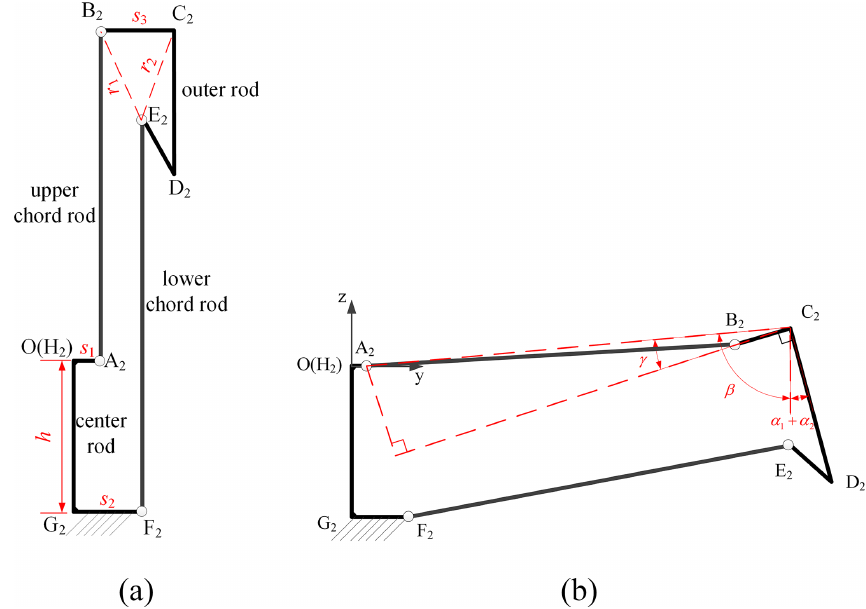
Figure 6. The basic rib mechanism 2. (a) Folded state. (b) Deployed state.